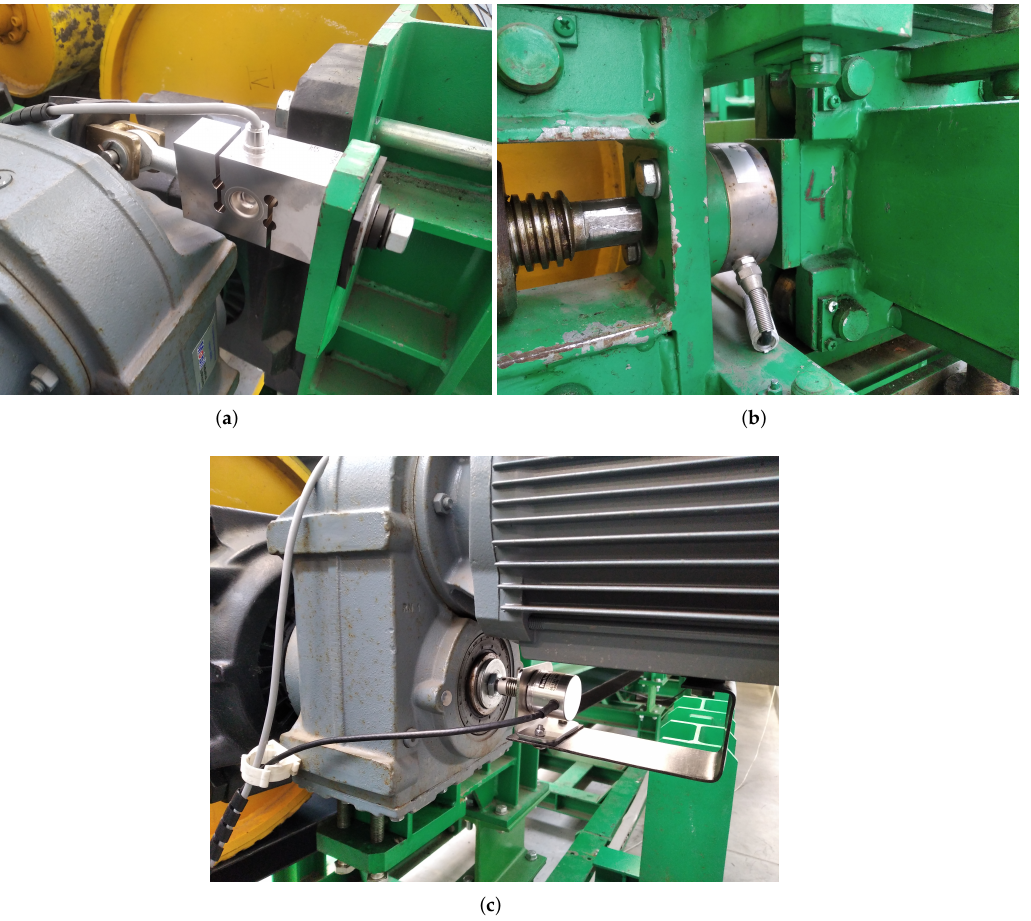
Figure 3. Measuring system: ( a ) load cell on the torque arm of the transmission to measure the torque on the shaft of the drive pulley, ( b ) load cell for measuring the belt tensile force (compressive force on the cylinder piston rod), ( c ) incremental encoder on the shaft of the drive pulley for RPM measurement. The resistance to motion of the rig is low and therefore the head drive of the main conveyor was excluded from use. In the presented series of tests, an intermediate drive on the head pulley and the return drive of the main conveyor operating in the braking system were used. This means that the conveyor was driven by the intermediate drive, and the drive at the return pulley of the main conveyor simulated increased resistance to motion. To enable such operating conditions, a vector control system for the operation of drive inverters was prepared. The data was processed using MATLAB